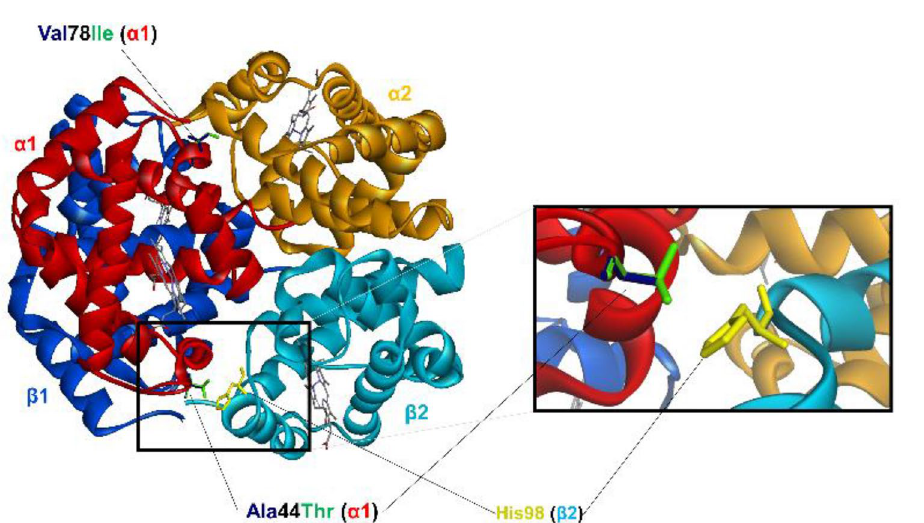
Figure 4. Ribbon representation of the superimposed Ala44Thr and Val78Ile variants of turbot ( Scophthalmus maximus ) HbαD together with the Hbβ1 subunit. Amino acid residues at positions 44α and 78α and the interacting His98β residue are shown in stick. The hydrophobic interaction between Ala44α1 and His98β2 is shown in the enlarged section. The heme groups are shown color-coded by atom